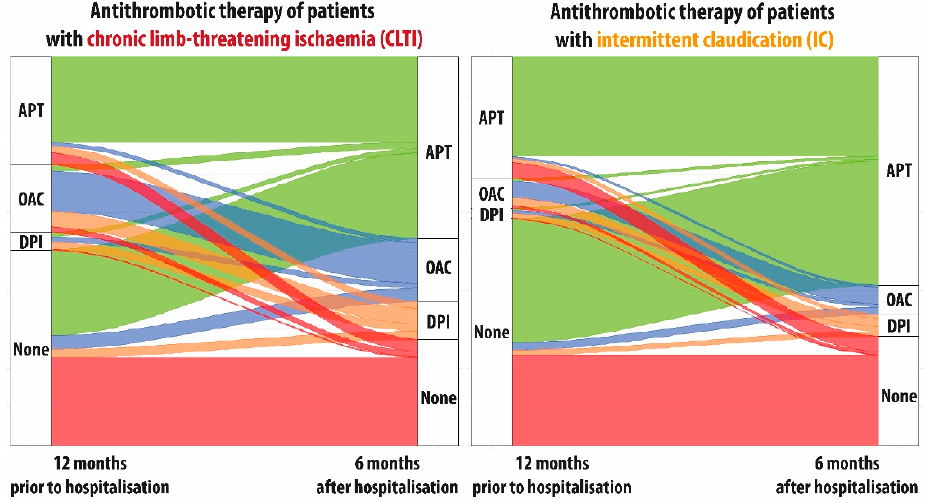
Figure 3. Alluvial diagram of proportions of patients with antithrombotic therapy 12 months before and 6 months after index stay for symptomatic peripheral arterial occlusive disease (PAOD). The different colours refer to the subgroups described at the right axis; APT: Antiplatelet therapy, OAC: Oral anticoagulation, DPI: Dual pathway inhibition, CLTI: Chronic limb-threatening ischaemia, IC: Intermittent claudication; only patients alive and fully insured up until 6 months after discharge from index stay were included (N = 71,794).